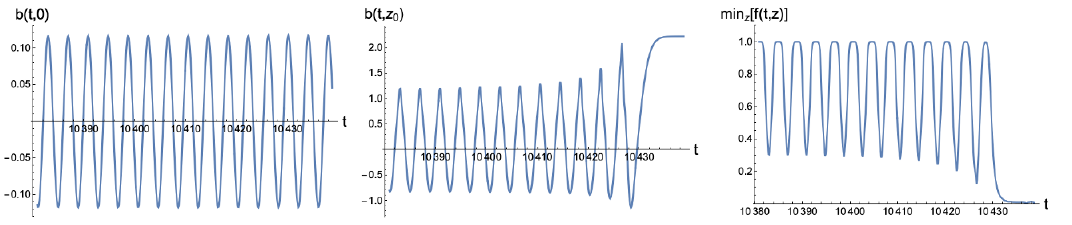
Figure 5 . The same scenario depicted in (cid:12)gure 4, where the (cid:12)nal part of the evolution is shown. The extreme slowness of the amplitude increase contrasts with the abruptness of the sudden collapse that occurs in a few oscillations. The anharmonicity of the oscillation, as well as the lack of symmetry b ! (cid:0) b , can be seen in the plot of b ( t; z 0 ) at the tip.